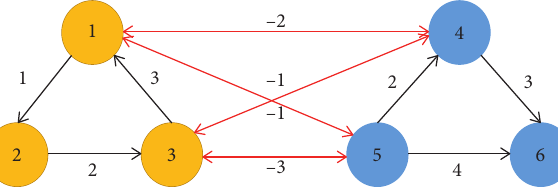
Figure 4: Directional topology of a multiagent system.